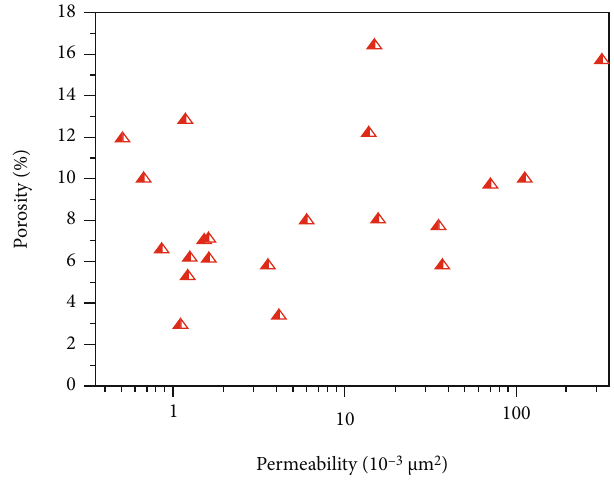
Figure 5: Plot of porosity vs. permeability for the carbonate